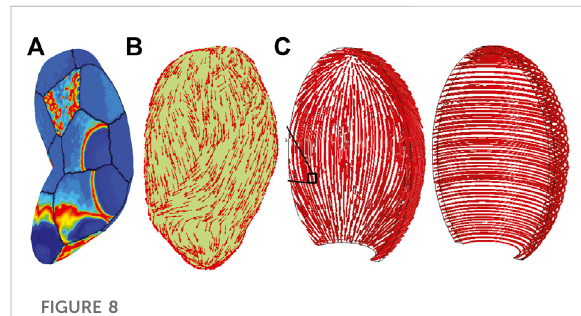
FIGURE 8 Three-dimensional organ simulations demonstrate tissue organizational dominant in fl uence on overall behavior. (A) Yochum et al., simulation result showing electrical activity in spatially-distant regions due to mechano-transductive coupling well ahead of tissue-surface action potential wave-front (Yochum et al., 2018); note lack of contractile fi bers over surface. (B) Organization of contractile fi bers over three-dimensional organsimulatedinZhangetal.,2016,andlayersoflongitudinaland circumferential fi ber layers ( ‘ fasciculi ’ ) in (C) Sharifmajid et al. (2016) inspired by observed patterns of fi ber and